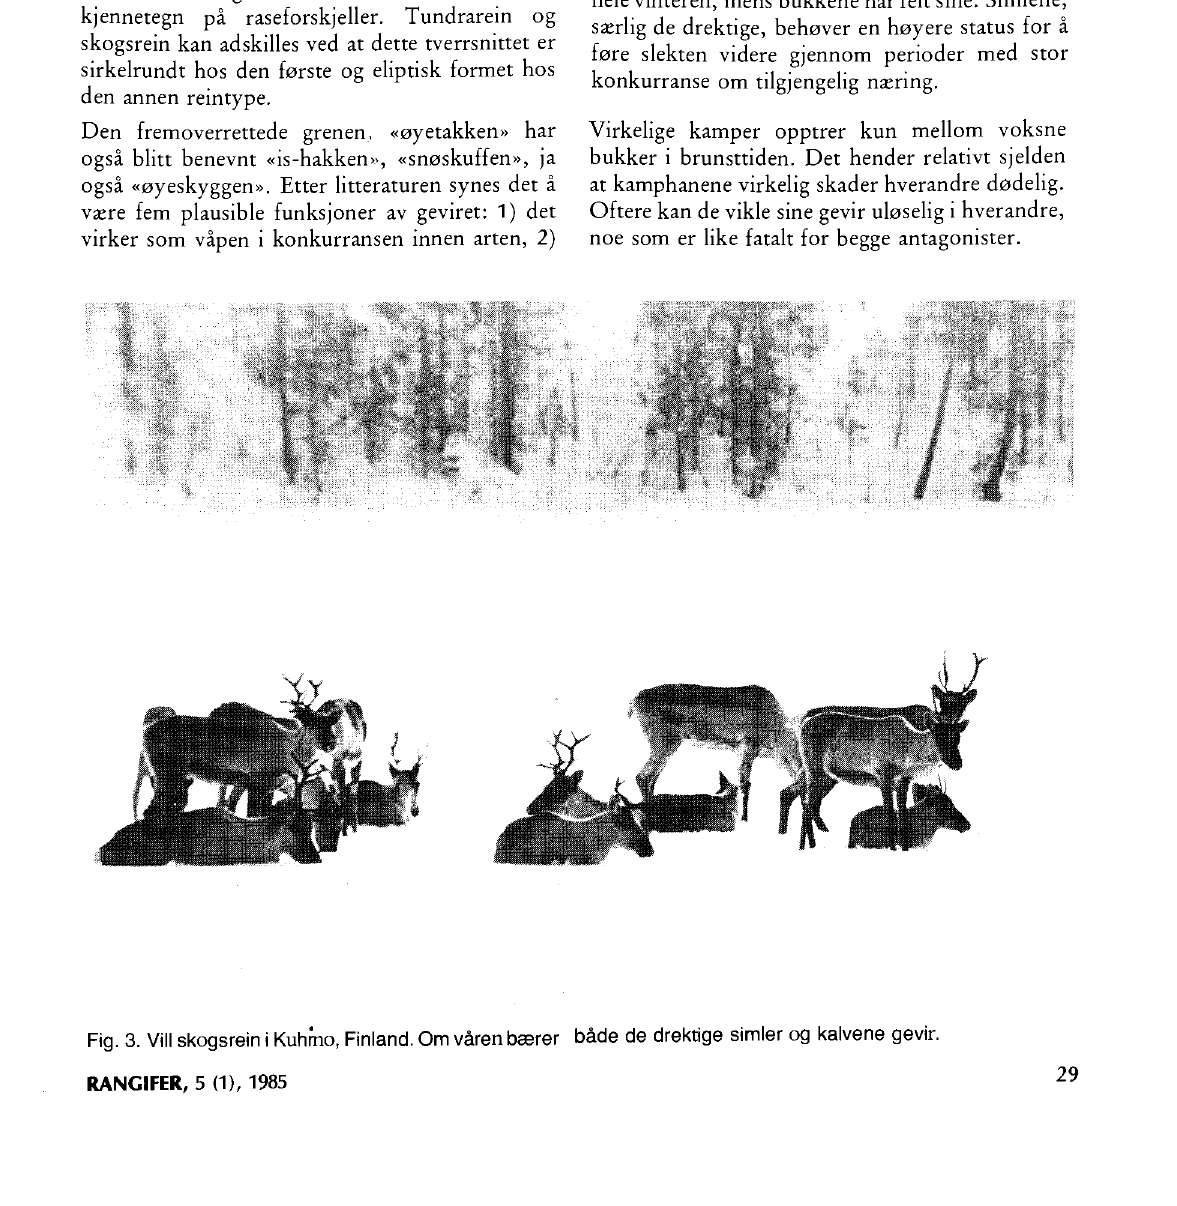
Fig. 3. Vill skogsrein i Kuhfno, Finland. Om våren bærer både de drektige simler og kalvene gevir. RANGIFER, 5 (1),